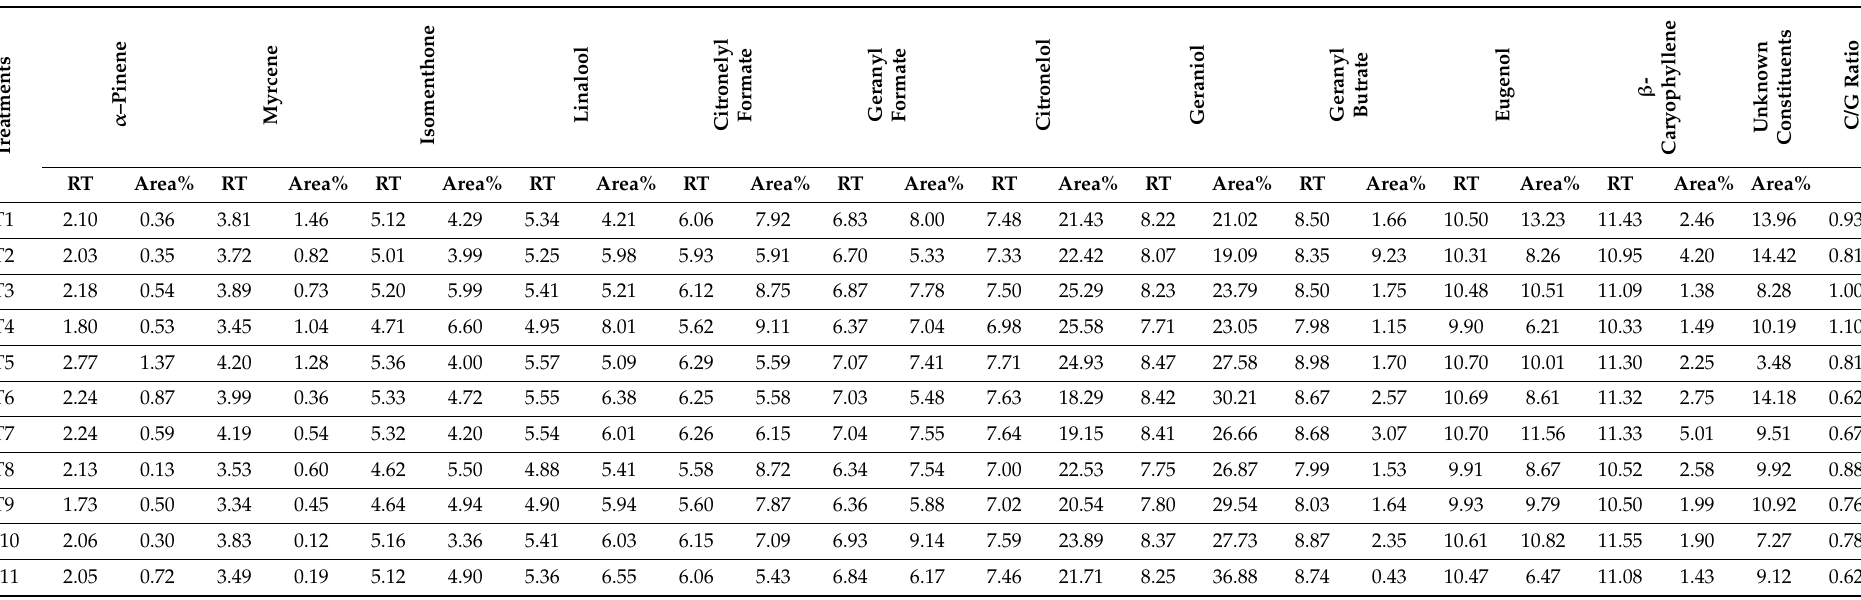
Table 4. Effect of iron (nano, sulfate, and chelated) foliar spray on essential oil active constituent’s retention time (RT) and percentage (area %) of Sweet Scented geranium in the first cut during the 2019 experimental season. Means of three replicates are presented with ±